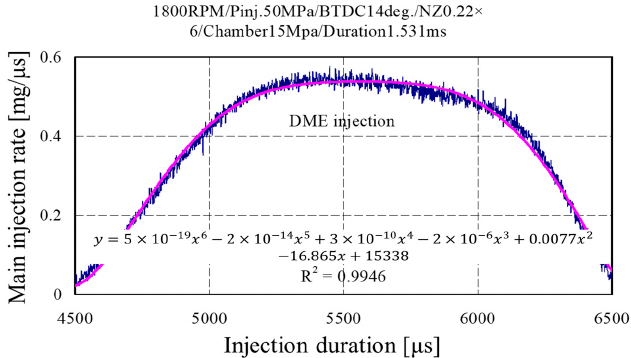
Figure 11. Injection rate characteristic for only the main injection quantity of the pilot and main injection durations for DME.